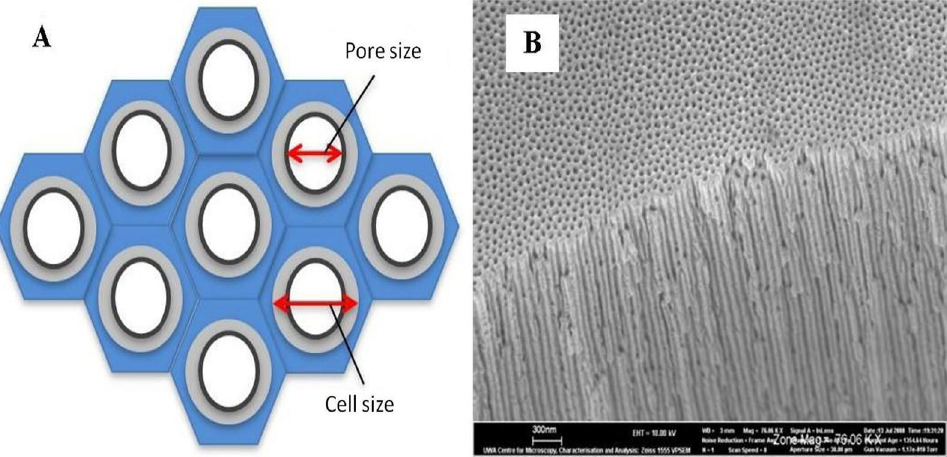
Fig. 8 A Schematic of the ideal densely packed hexagonal array of pores; B Actual cross-sectional view of a typically synthesized AAO layer (Poinern et al.